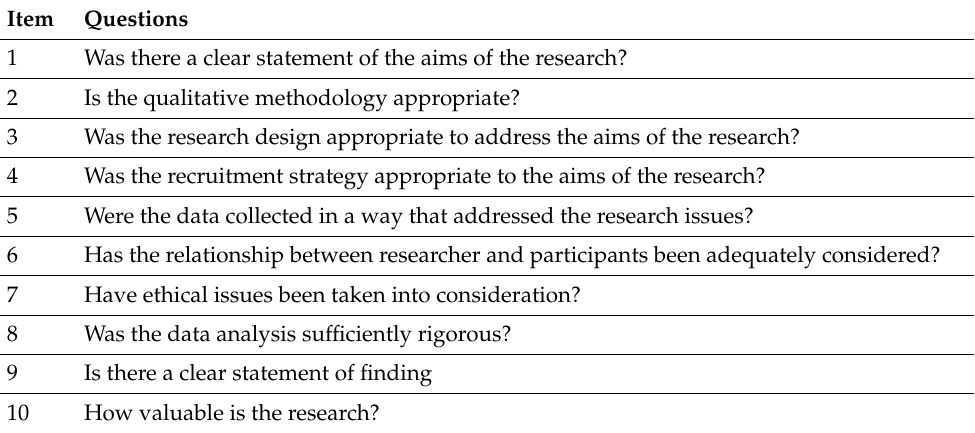
Table 2. Critical appraisal Skills Program Tool.